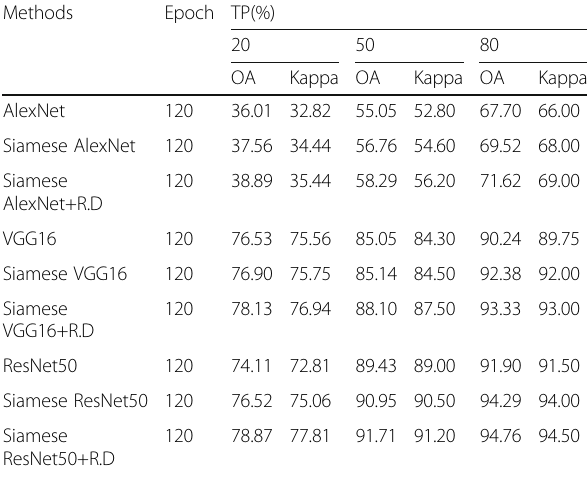
Table 3 Comparison of OA (%) and Kappa (%) on UC Merced Land-Use data set